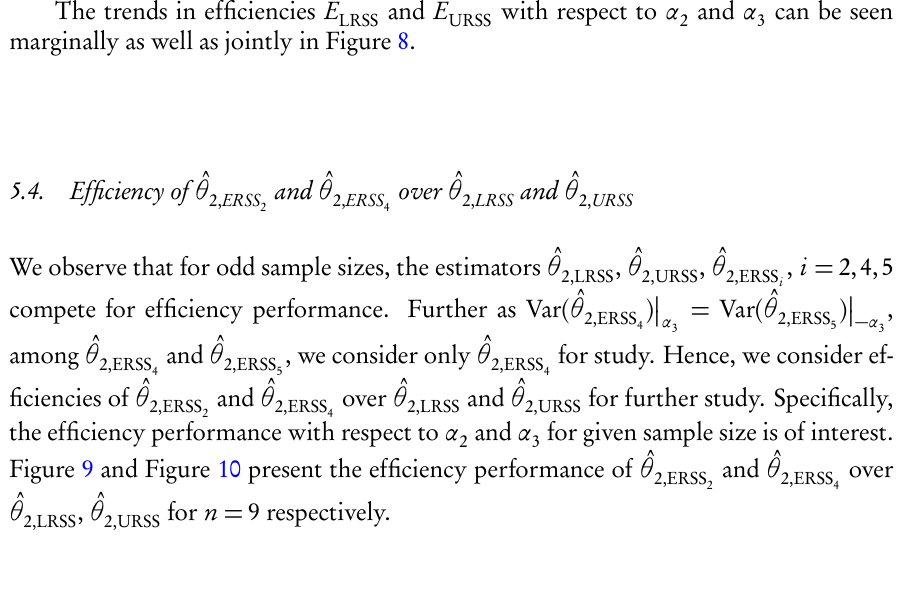
Figure 9 – Efficiency of ˆ θ